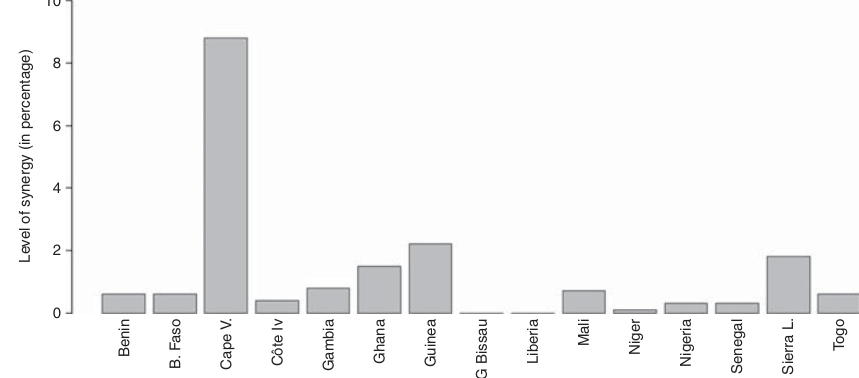
Table V. Difference between Nucleolus and Shapley value of actors of the Triple Helix system of selected countries